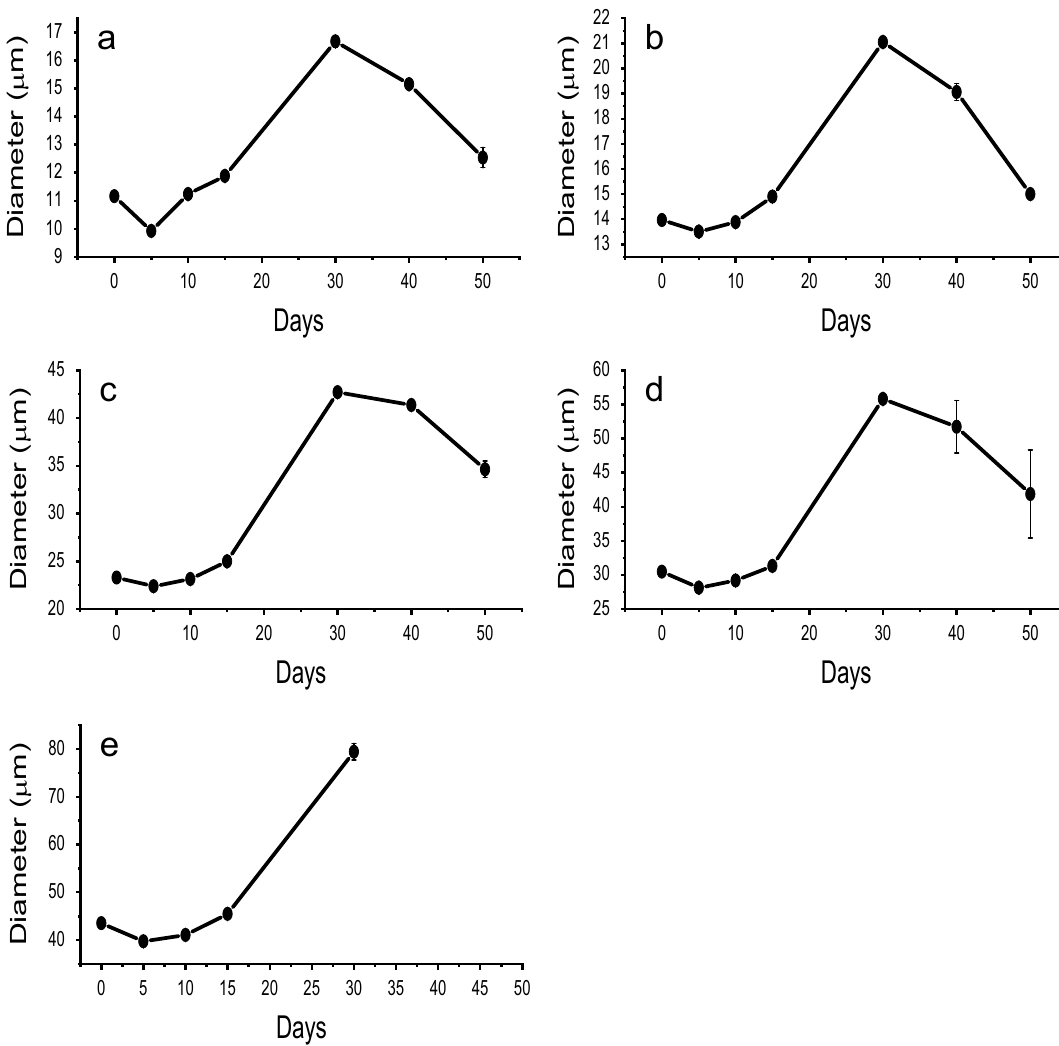
Figure 5. Swelling profiles of various microparticle population sizes: 11 µm ( a ), 14 µm ( b ), 23 µm ( c ), 30 µm ( d ), and 44 µm ( e